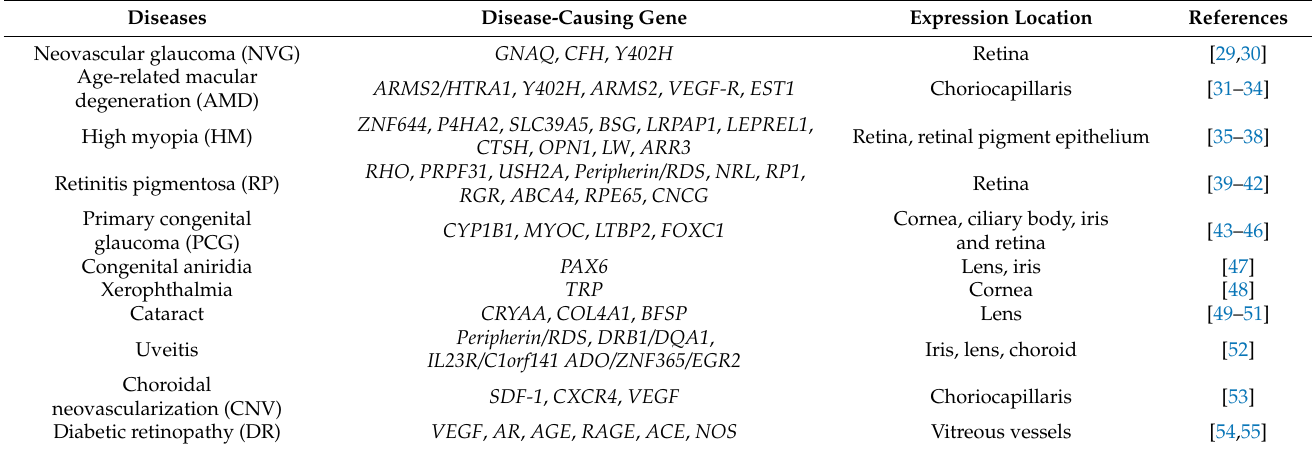
Table 2. Identified Disease-causing Genes In ophthalmopathy.